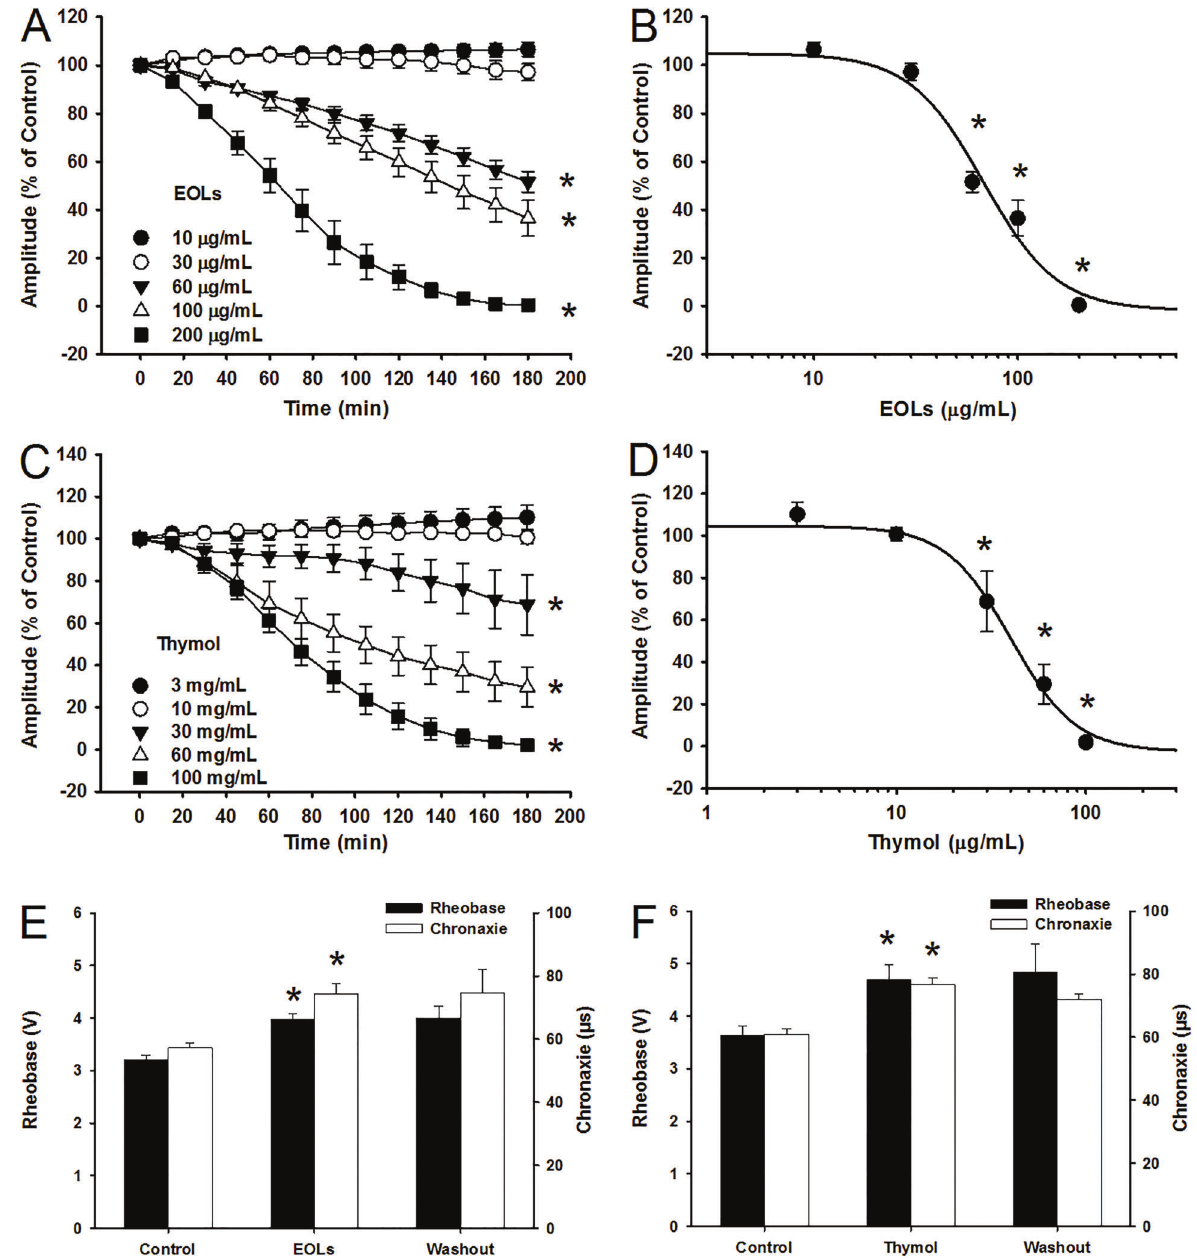
Figure 2. Amplitudes and excitability parameters of compound action potential. Panels A and C present the time course of essential oil of L. sidoides (EOLs) and thymol effects on peak-to-peak amplitude, and panels B and D show concentration-response curves for EOLs and thymol, respectively. Panels E and F show effects of EOLs (60 m g/mL) and thymol (60 m g/mL; 0.4 mM) on rheobase and chronaxie. Data are reported as means ± SD. *P o 0.05 compared to control (ANOVA followed by Bonferroni ’ s post hoc